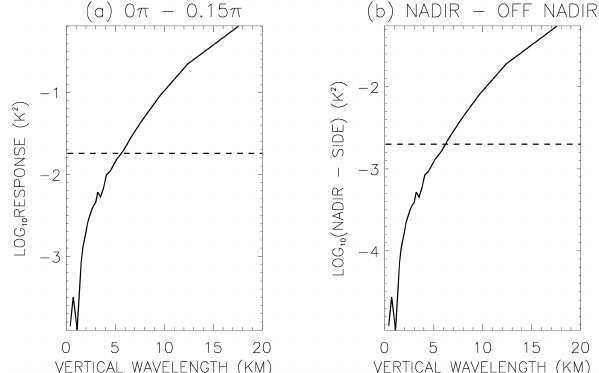
Fig. 11. (a) Weighting function over nadir at 80hPa as a function of Fig.11. (a) Weightingfunctionovernadirat80hPaasafunctionof height and along-track distance for the numerical simulation. The height and along-track distance for the numerical simulation. The contours are 0.5, 0.7, 0.9 and 0.99 of the peak response. The out- contours are 0.5, 0.7, 0.9 and 0.99 of the peak response. The out- mostoff-nadirweightingfunctionis4timesbroaderthanthatofthe most off-nadir weighting function is 4 times broader than that of the nadir. (b) One example of the original input wave convolved with the nadir weighting function (lines) and resultant wave with 0 . 15 π nadir. (b) One example of the original input wave convolved with phase shift (shades). The wave has horizontal wavelength ( λ x ) of the nadir weighting function (lines) and resultant wave with 0 . 15 π 100km and vertical wavelength ( λ z ) of 6km. Negative values are contoured with dash-dot lines (light colors), and positive values are phase shift (shades). The wave has horizontal wavelength ( λ x ) of denoted withsolid lines (darkcolors). Thecontour intervalis 0.2of 100km and vertical wavelength ( λ z ) of 6km. Negative values are the maximum and minimum amplitudes, respectively. contoured with dash-dot lines (light colors), and positive values are denoted with solid lines (dark colors). The contour interval is 0.2 of the maximum and minimum amplitudes, respectively.